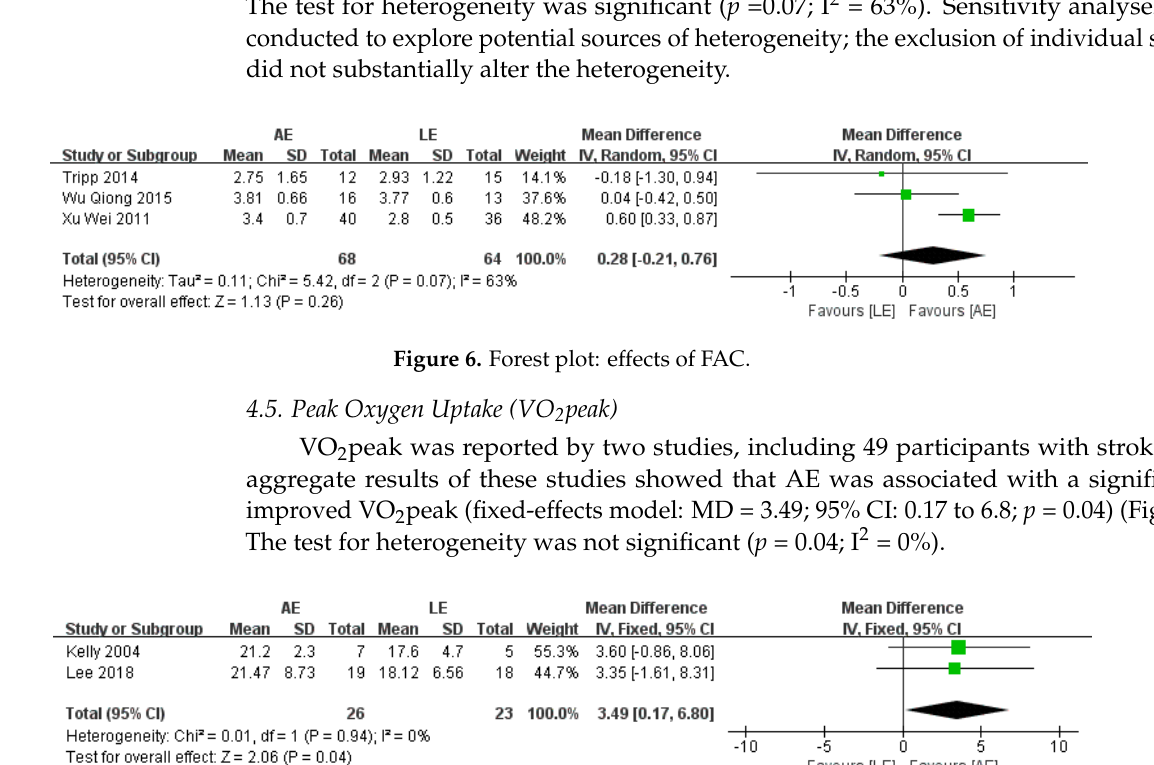
Figure 5. Forest plot: effects of TUGT.